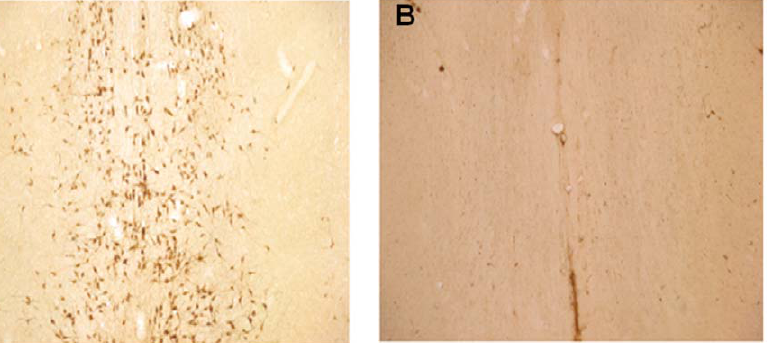
Figure 1. Infusion of 192-saporin results in lesioning of cholinergic neurons. Photomicrographs (50 6 magnification) of MS region immunostained with anti-ChAT antibody in (A) a saline infused rat and (B) in a rat infused with